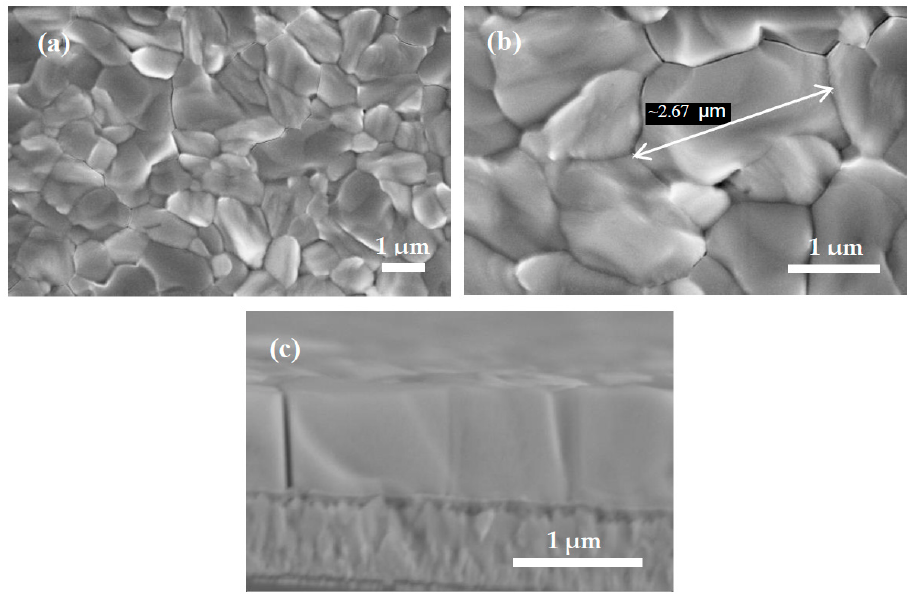
Figure 7. SEM images: ( a , b ) Top-view SEM images of FTO/TiO 2 /SnO 2 /perovskite; ( c ) Cross-sectional SEM image of FTO/TiO 2 /SnO 2 /perovskite.